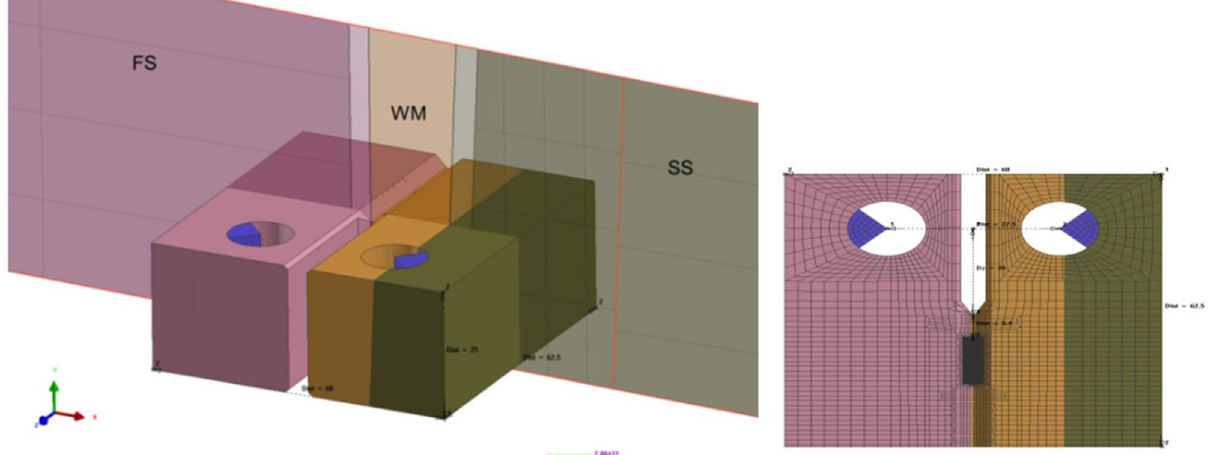
Fig. 2. Position and meshing of a CT25 specimen (MU1).